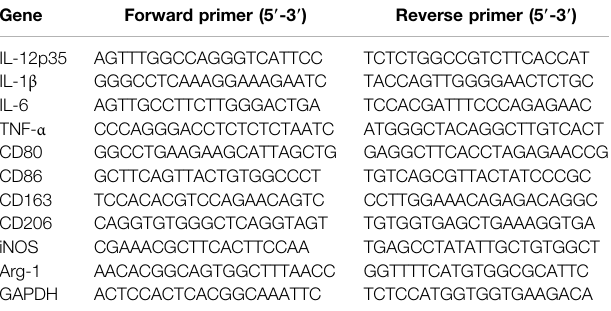
TABLE 1 | Primers for quantitative polymerase chain reaction. Gene Forward primer (5 9 -3 9